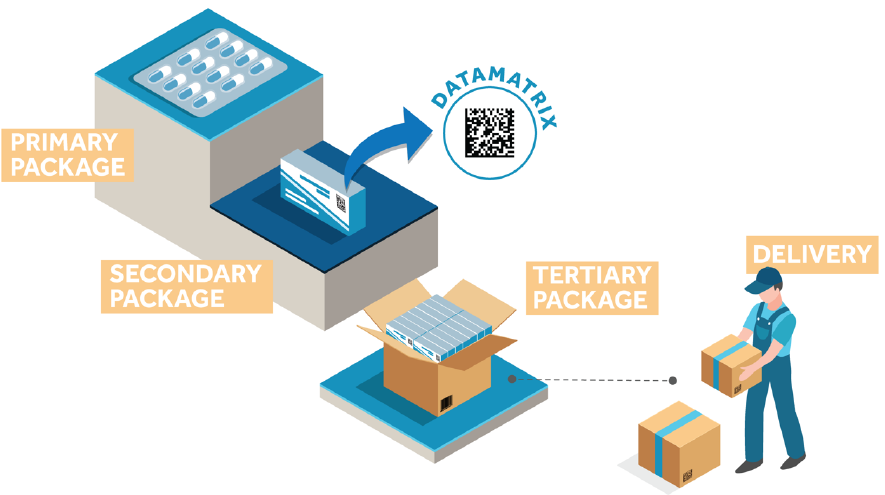
Figure 2. Packaging levels schematic. Adapted from